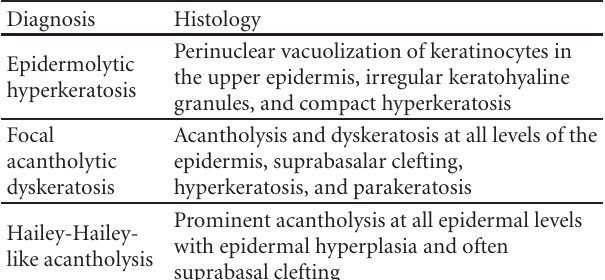
Figure 1: Incidental epidermolytic hyperkeratosis occurring in associationwith a dysplastic junctional nevus. (200X magnification, hematoxylin, and eosin stain).